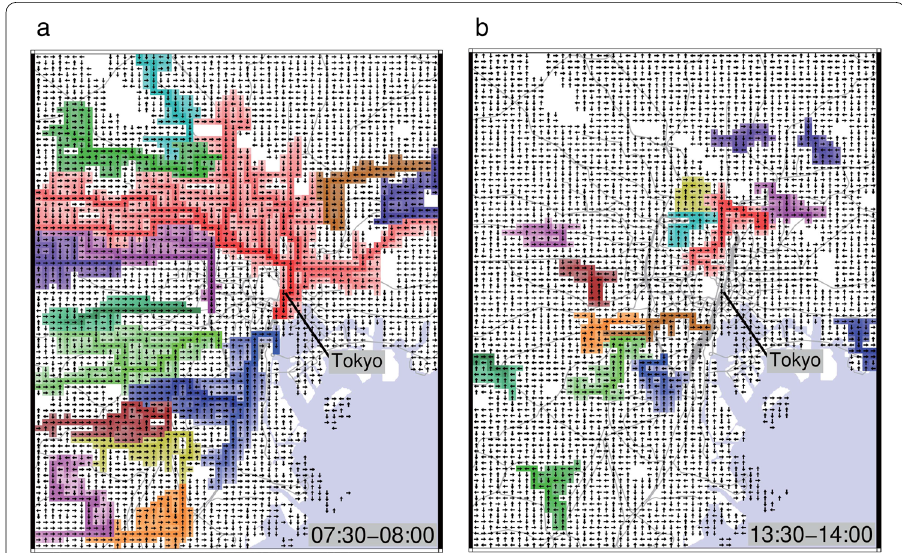
Fig. 7 Drainage basins around Tokyo metropolitan area in the year 2016. a , b , Flow maps of basins in a the morning commuter rush hour (07:30–08:00) and b the afternoon (13:30–14:00) in the Tokyo metropolitan area, where the largest 15 basins are shown in different color codes. The display area is about 20–30 km square. The analysis range is the whole year of weekday